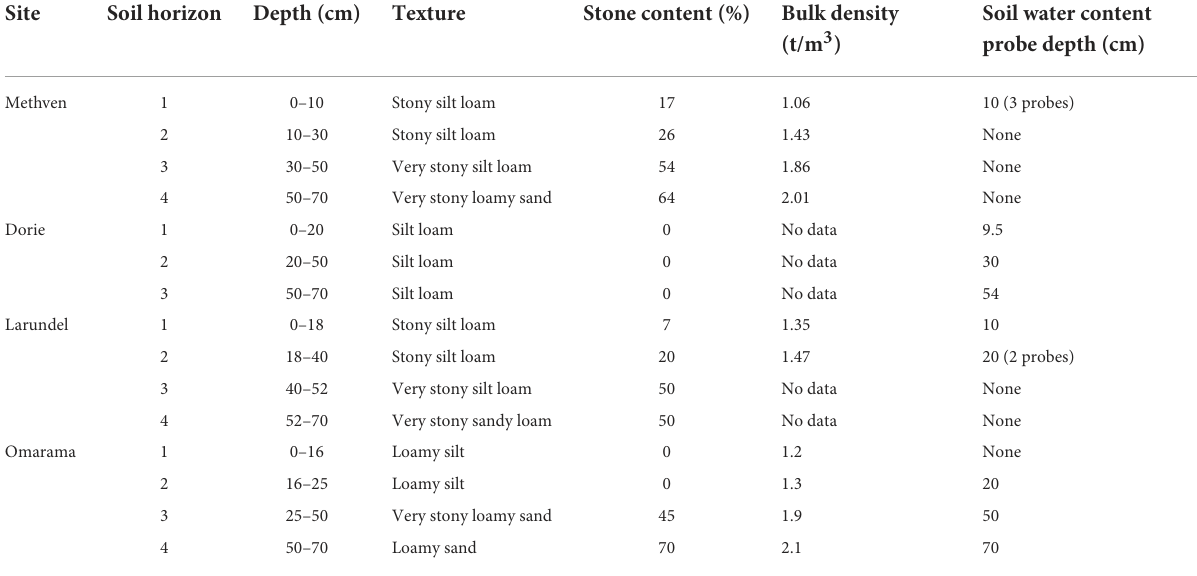
TABLE 5 Soil and soil water content probe information at Canterbury